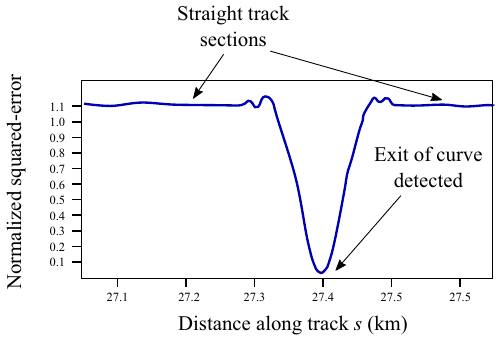
Figure 12. Normalized